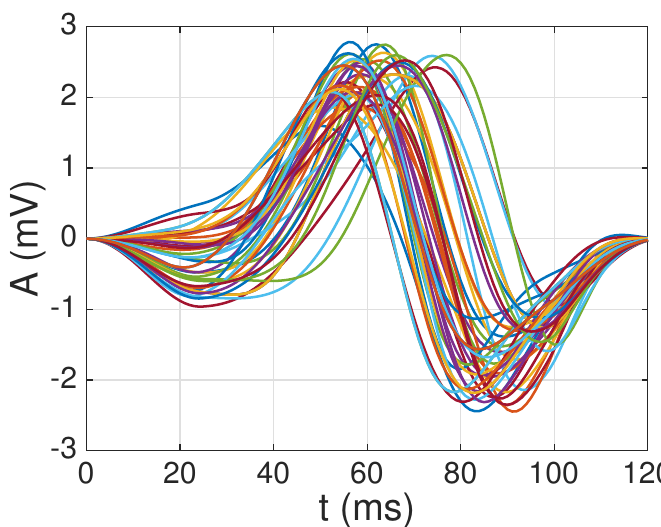
Figure 5. Q (cid:48) = 44 reliable average QRS complexes extracted from the Q = 51 healthy patients in the PTB database [29] after resampling, windowing and normalization.